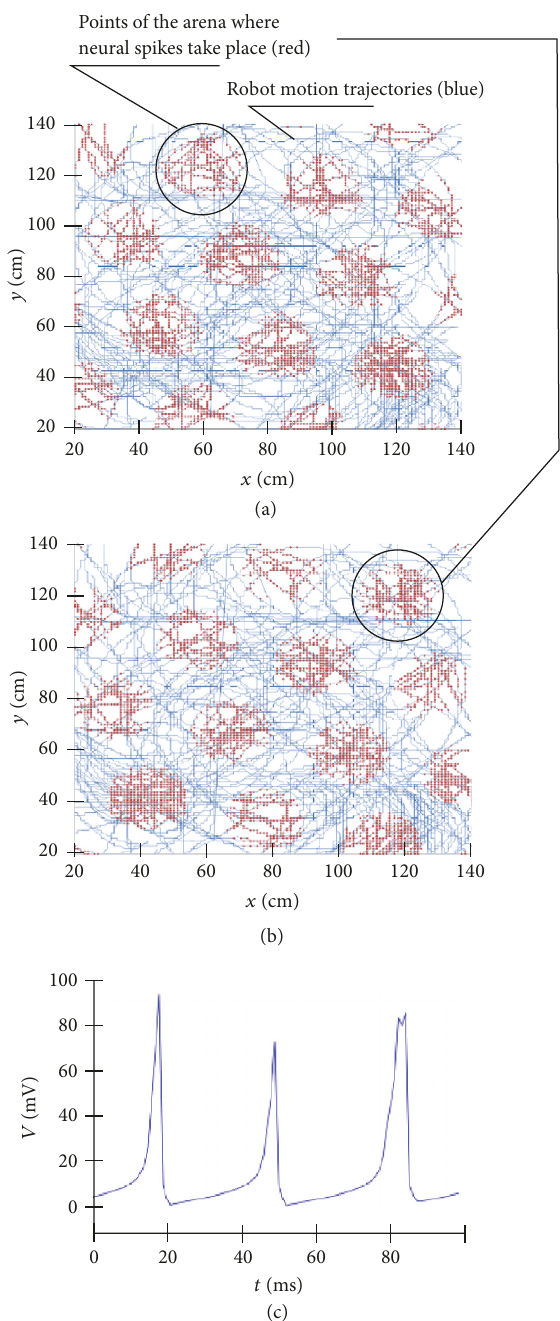
Figure 8: (a) Experimental map showing firing rate distribution for same grid cell with 𝜆 = 2.69 m −1 (spike locations of grid cell are superimposed on robot’s trajectory), (b) with 𝜆 = 2.74 m −1 ; (c) an example of numerical integration of grid cell potential-membrane spikes (see (3)) for a given static robot position. Please, observe the triangular array of